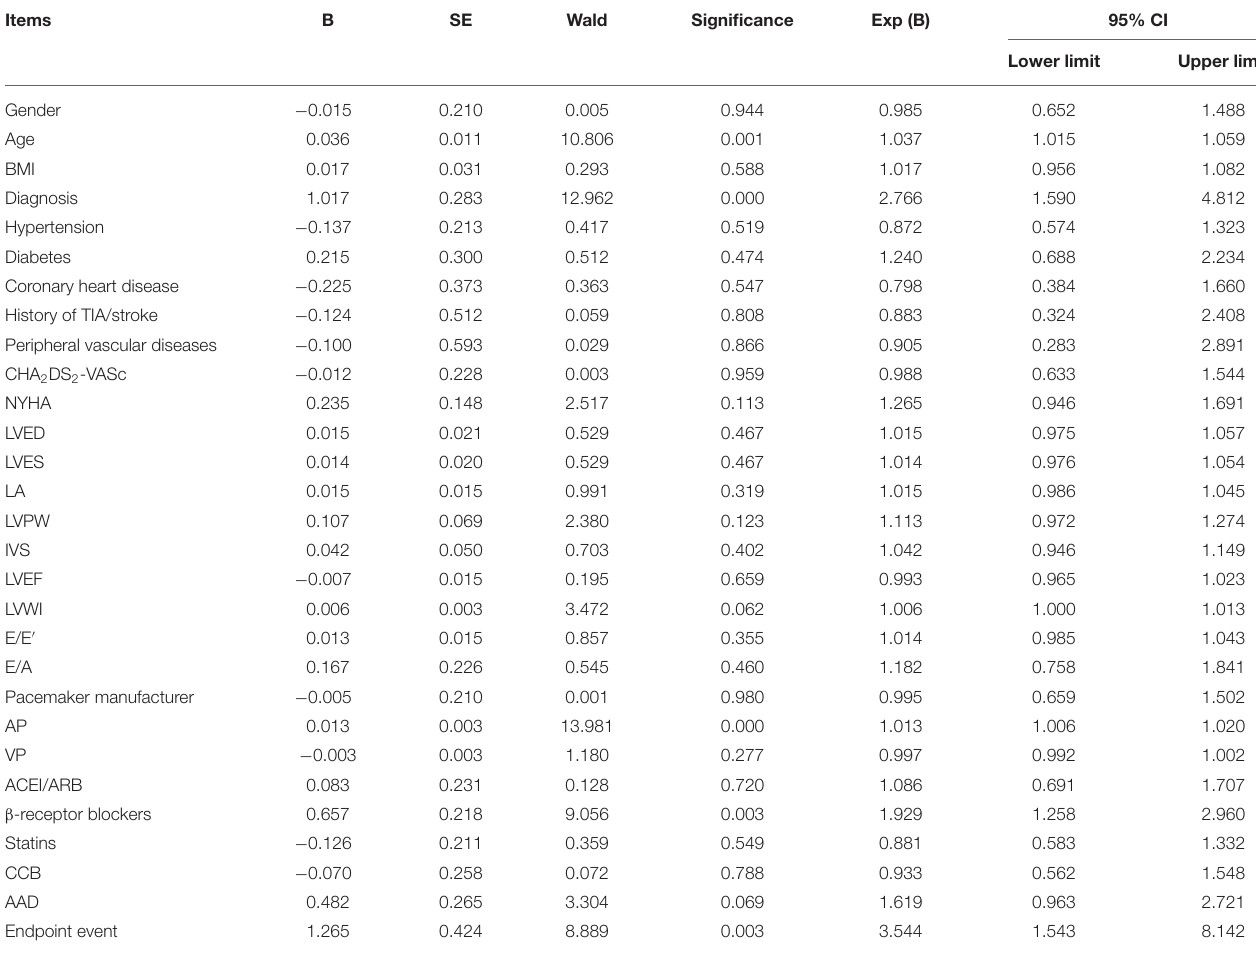
TABLE 7 | Univariate Cox’s regression analysis of AHRE.